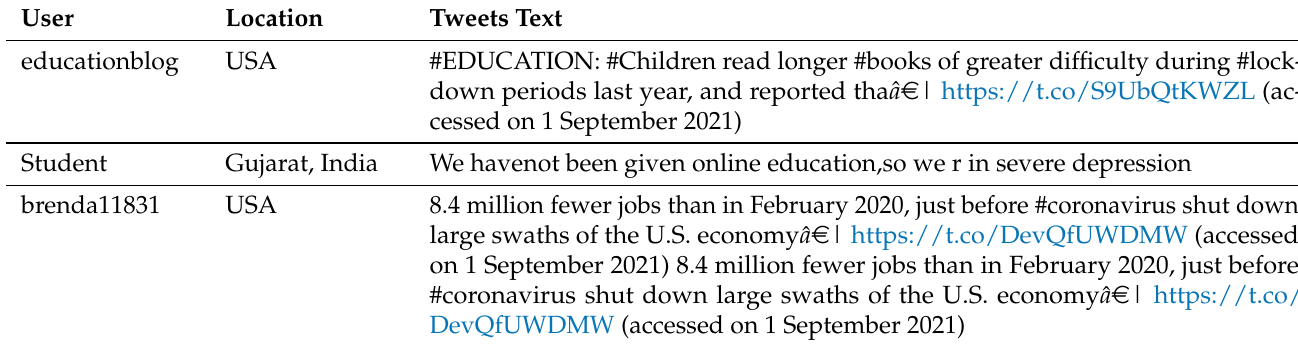
Table 2. Sample tweets from the collected dataset.